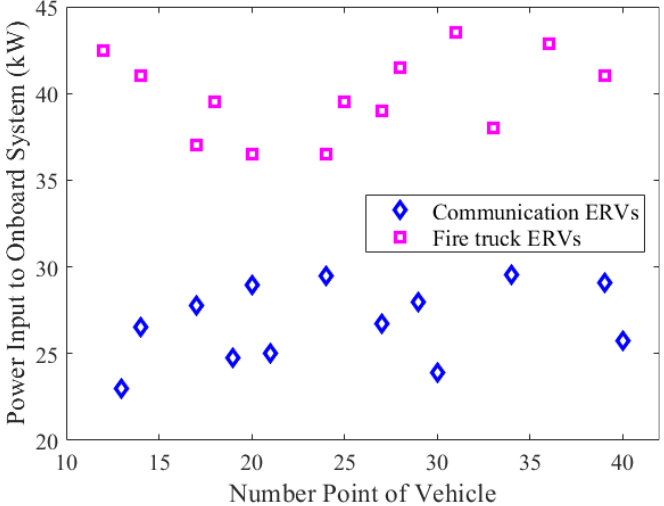
Figure 13. SVM classification of emergency rescue vehicle. Table 6. SVM classification of emergency rescue